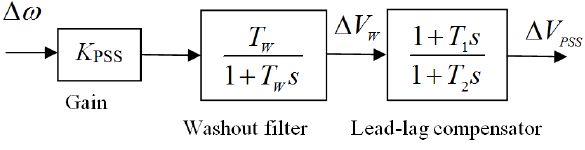
Figure 4. The model of the SMIB system with AVR and communication delay.